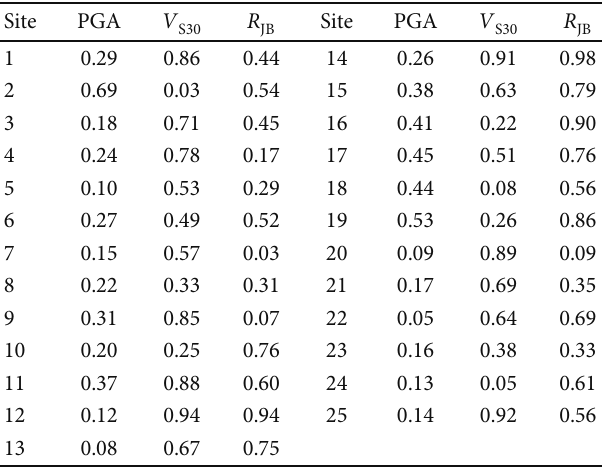
Table 3: A subset of the Imperial Valley earthquake data in